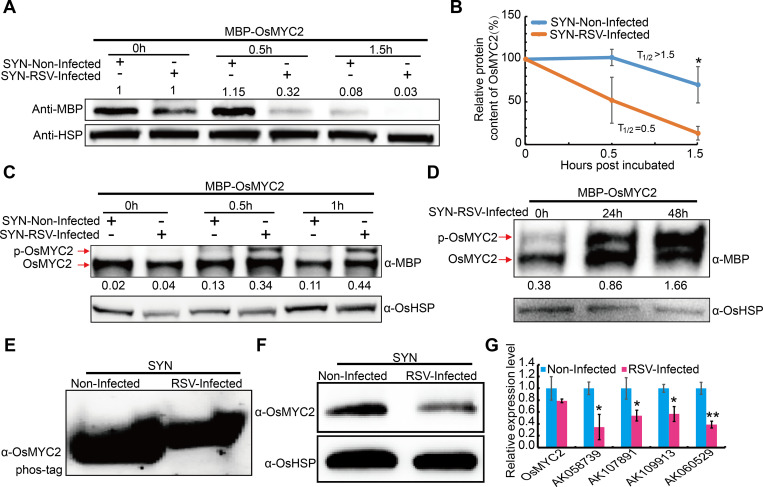
RSV infection induces the degradation of OsMYC2 by phosphorylation.(A) OsMYC2 protein levels in the RSV-infected and non-infected SYN rice plants. OsHSP indicates loading control. The number on the panel indicate the protein level of MBP-OsMYC2 relative to its initial value (0 h). The experiment was repeated four times. (B) Half-life plot for cell-free degradation of MBP-OsMYC2 in (A). (C) Phosphorylation levels of MBP-OsMYC2 incubated with the extracts from RSV-infected and non-infected rice plants using Phos-tag gels. The number under the panel indicate the ratio of pOsMYC2 versus OsMYC2. The experiment was repeated two times. (D) Determination of protein phosphorylation levels incubated with the extracts from rice plants collected at 0, 24 and 48 h post infection with RSV using Phos-tag gels. The number under the panel indicate the ratio of pOsMYC2 versus OsMYC2. The experiment was repeated three times. (E) Phosphorylation analysis of OsMYC2 in RSV-infected and non-infected plants using Phos-tag gels. The experiment was detected four independent RSV-infected and non-infected plants, respectively. (F) OsMYC2 protein levels in the RSV-infected and non-infected SYN rice plants. OsHSP indicates loading control. (G) The transcript levels of representative defense-related genes downstream of OsMYC2 in RSV-infected and non-infected SYN rice plants. AK058739 (subtilisin/chymotrypsin inhibitor), AK107891 (lipid transfer protein), AK109913 (similar to thaumatin-like protein) and AK060529 (beta-1, 3-glucanase). Data are shown as mean ± SEM (n > 3). *P < 0.05, **P < 0.01 by the Student’s t-test in B and G.